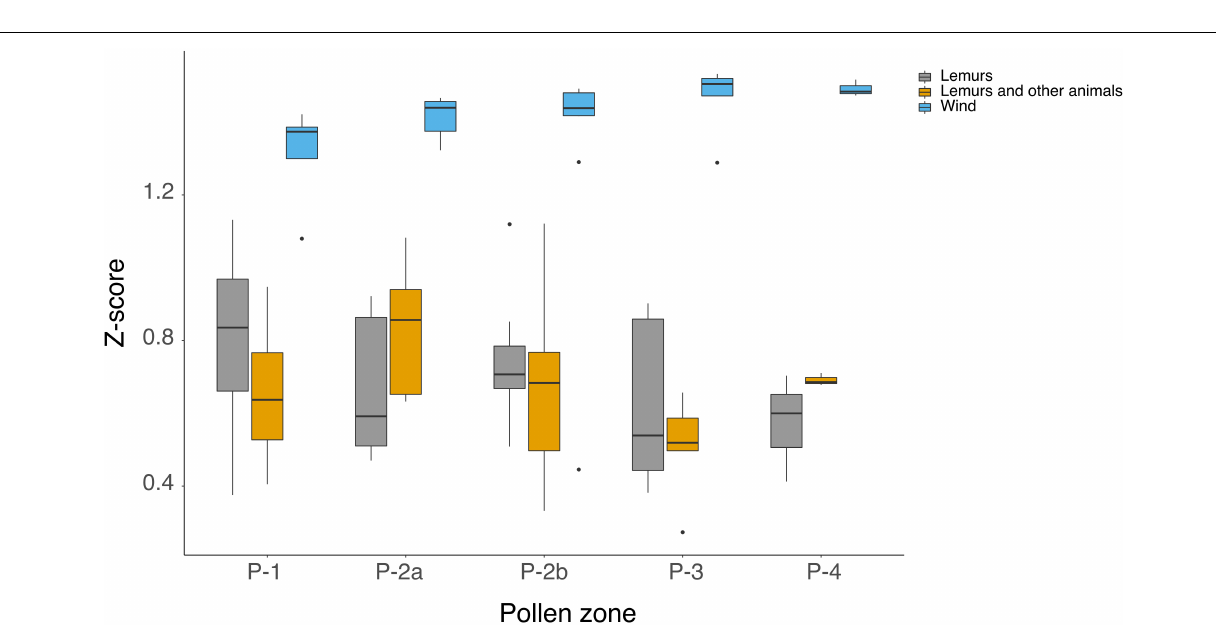
Frontiers in Ecology and Evolution |